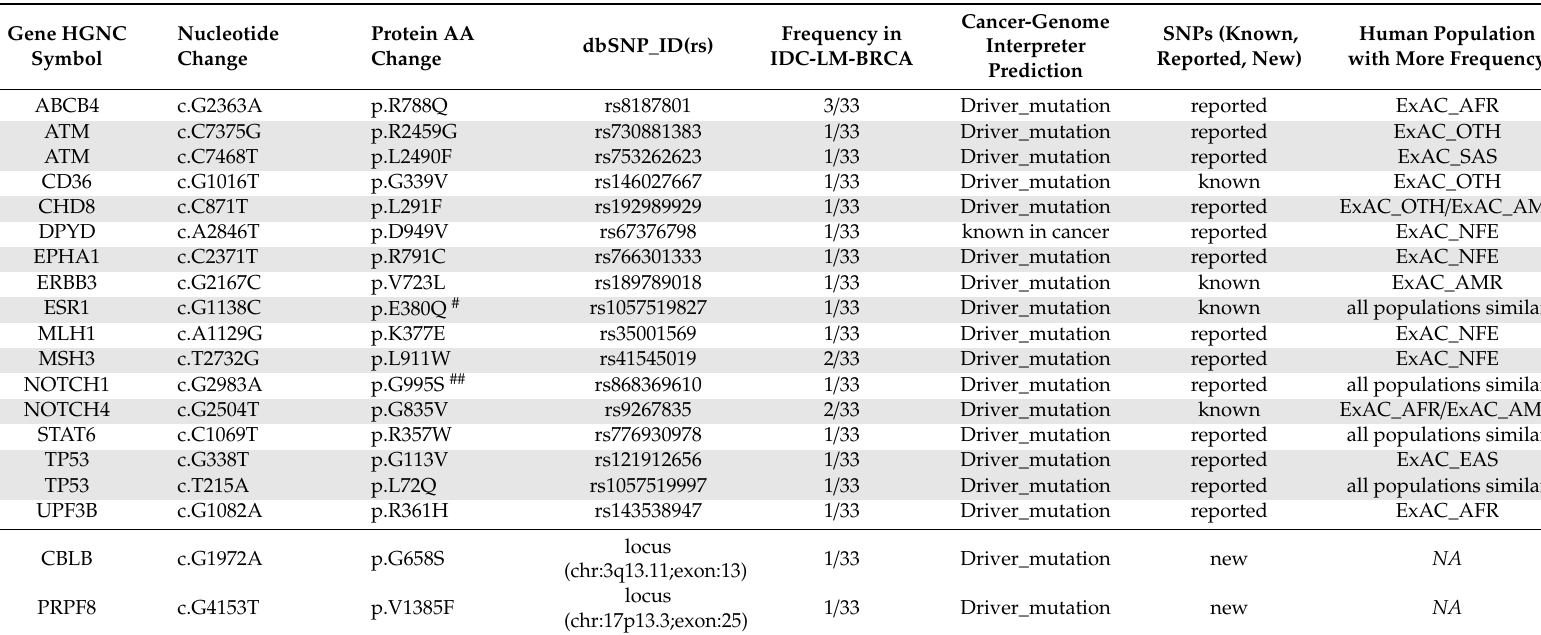
Table 1. Genes and associated exonic variants, presented as driver mutations (known or predicted) of breast cancer in women from Southwest